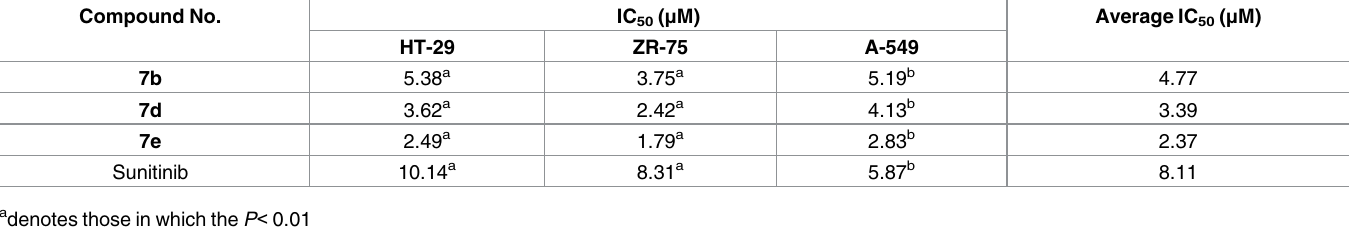
Table 2. Inhibitory concentration 50% (IC 50 ) of anti-proliferative activity of the selected compounds 7b, 7d, 7e and sunitinib against HT-29, ZR-75 and A-549 cell lines. Compound